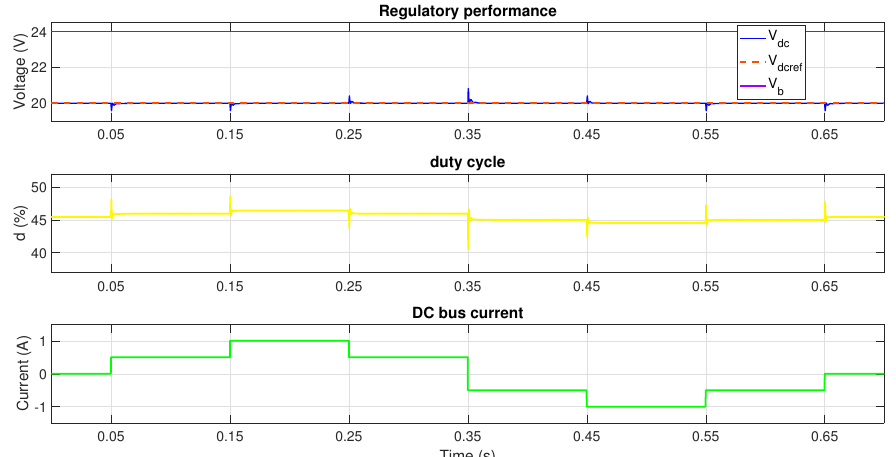
= 20 V (buck mode). ref